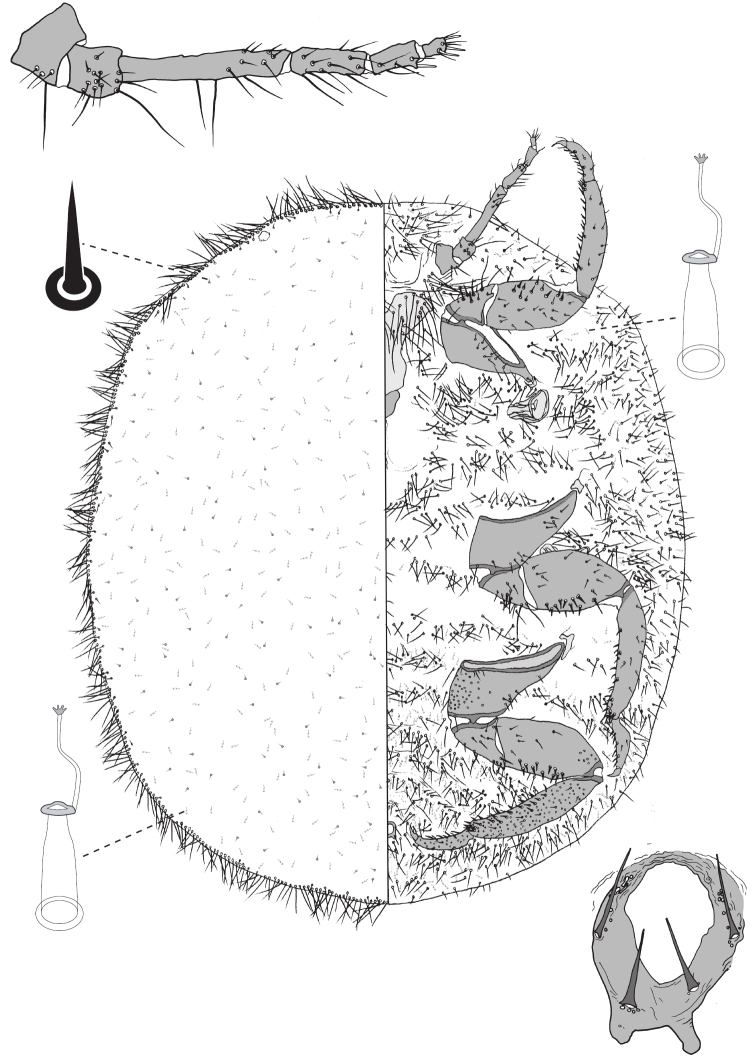
Adult female of Lachnodiushirsutus (Froggatt).